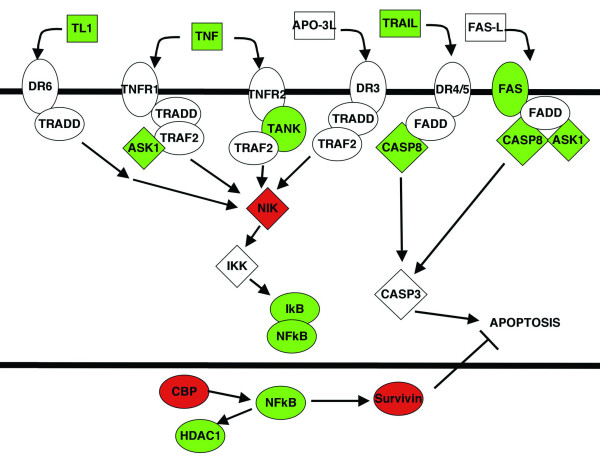
Effect of SV40 ST on Death Receptor Pathways. The diagram is colored as in Figure 5. SV40 ST downregulates pro-apoptotic components of all death receptor pathways and upregulates anti-apoptotic components such as survivin.